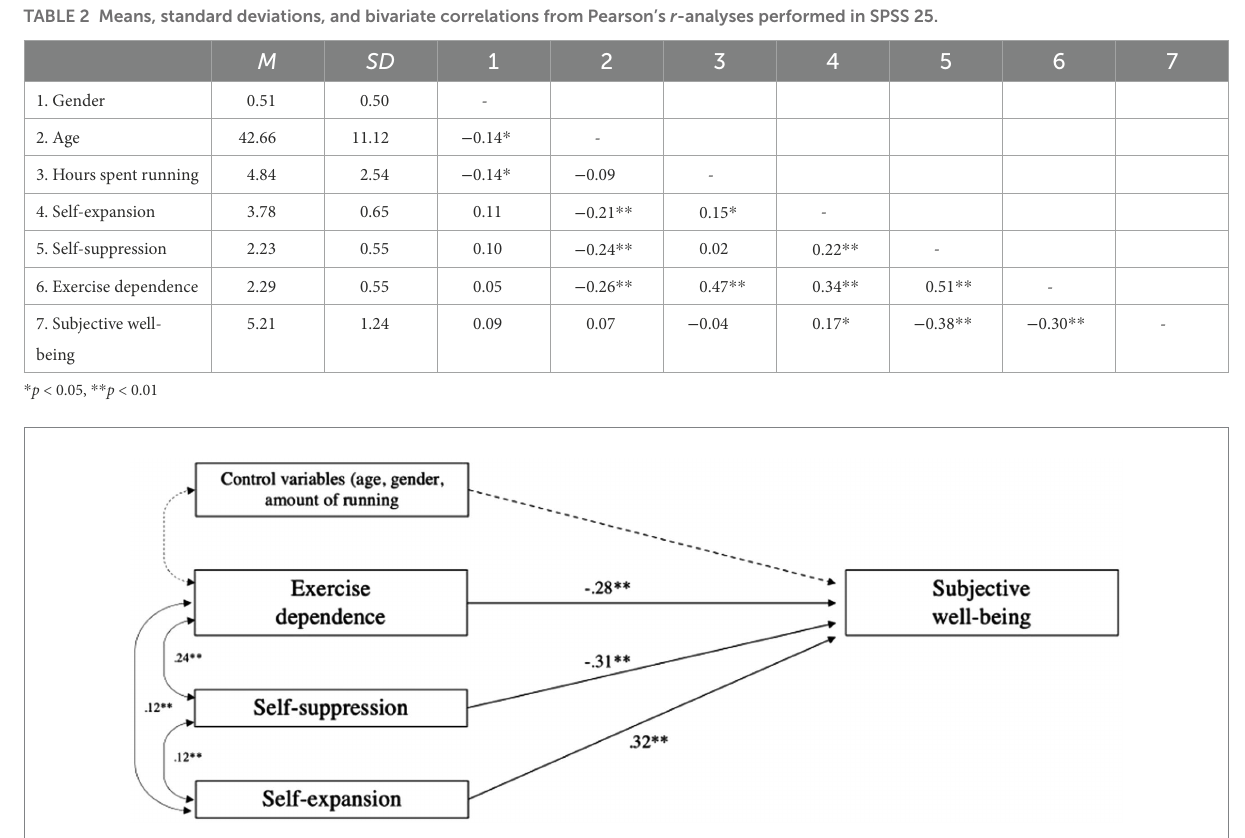
FIGURE 1 Path coefficients (Standardized Betas) and covariates for the full path model tested in AMOS 28. ** p <